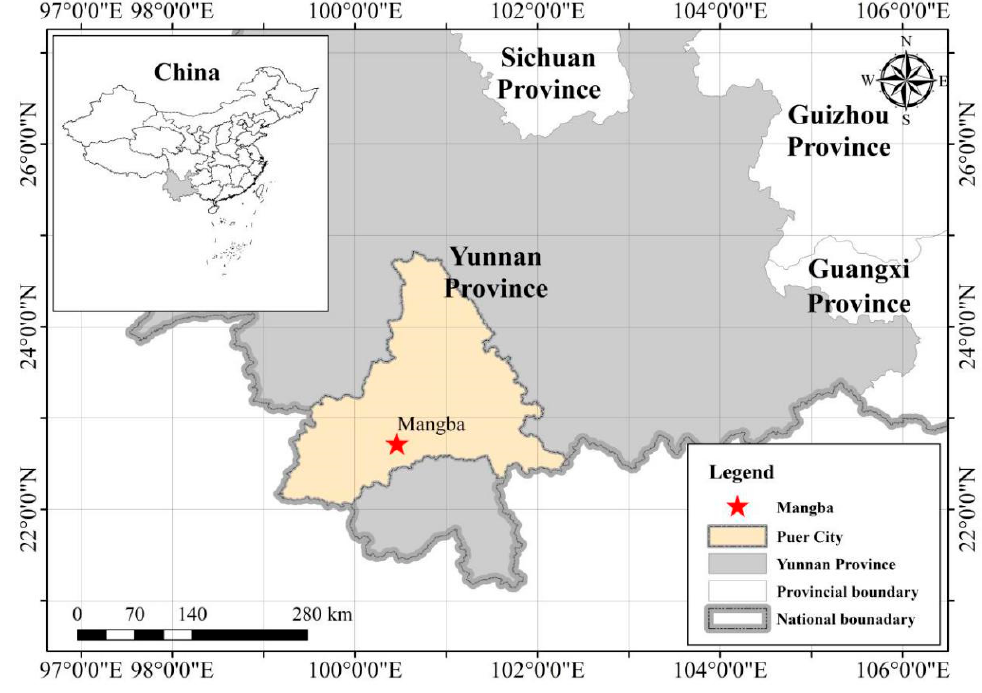
Figure 1. Location of the Mangba village.